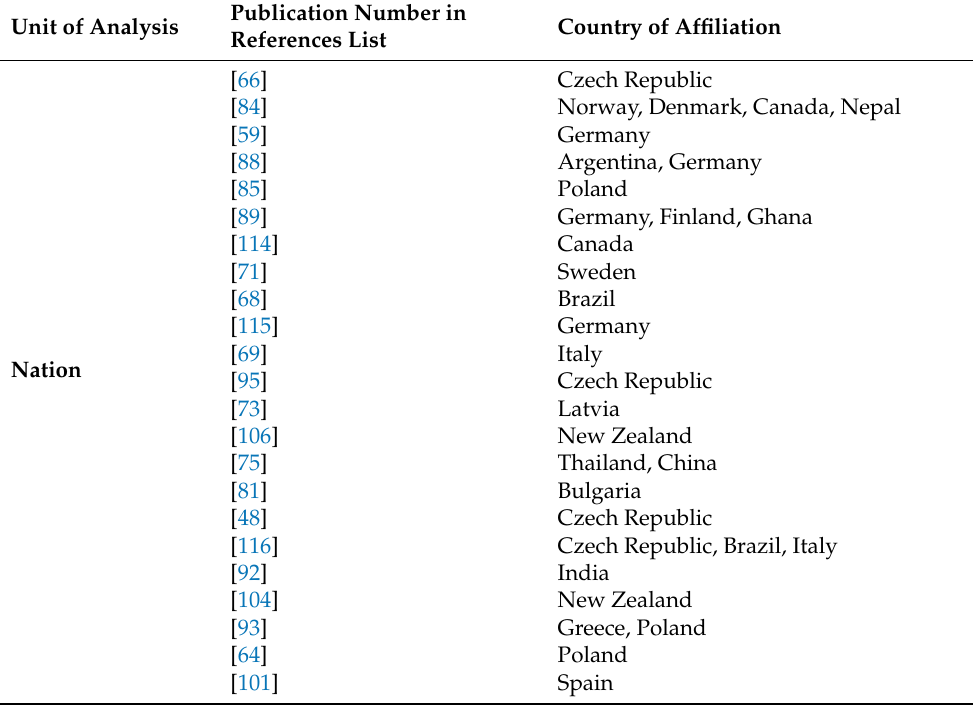
Table A1. Overview of publications by unit of analysis and country of